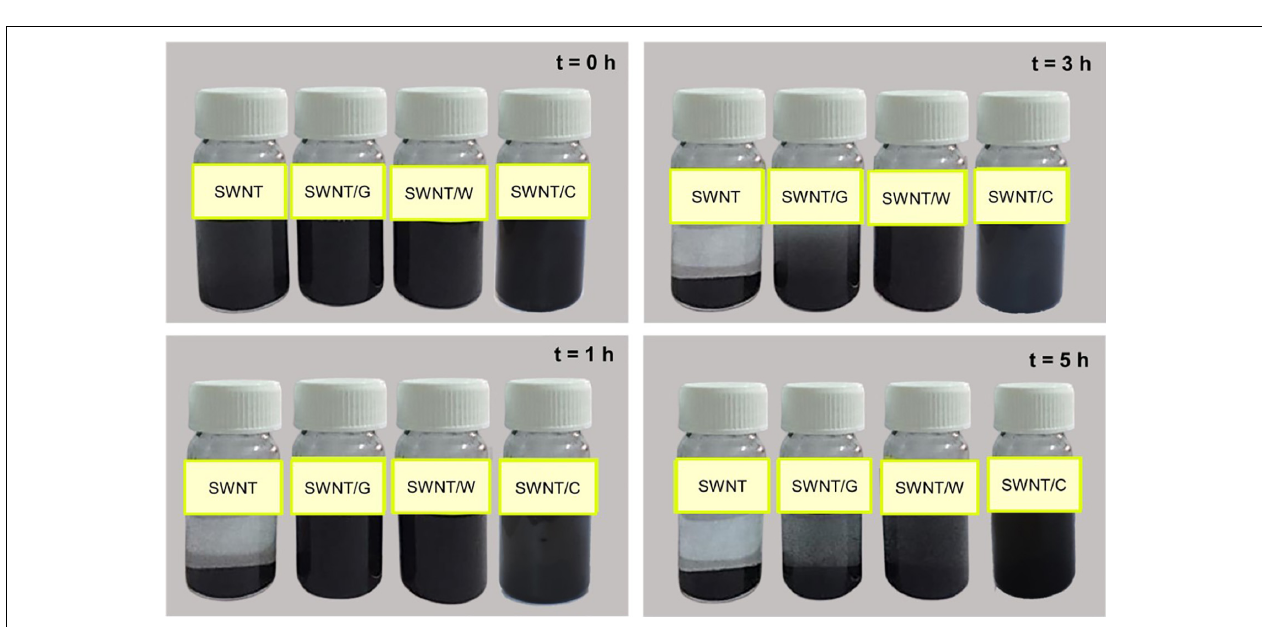
FIGURE 5 | Distribution of SWNTs, SWNT/G, SWNT/W, and SWNT/C in water.